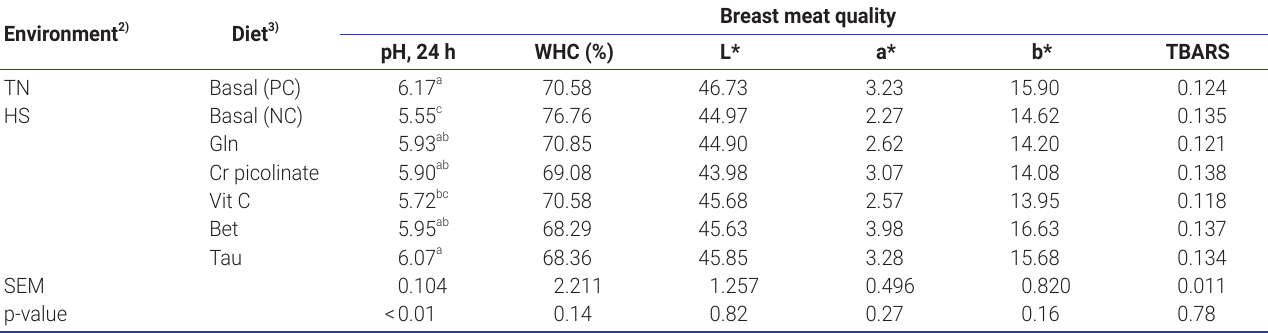
Table 3. Effects of dietary supplementation of various functional nutrients on breast meat quality of broiler chickens raised under heat stress con- ditions 1) Environment